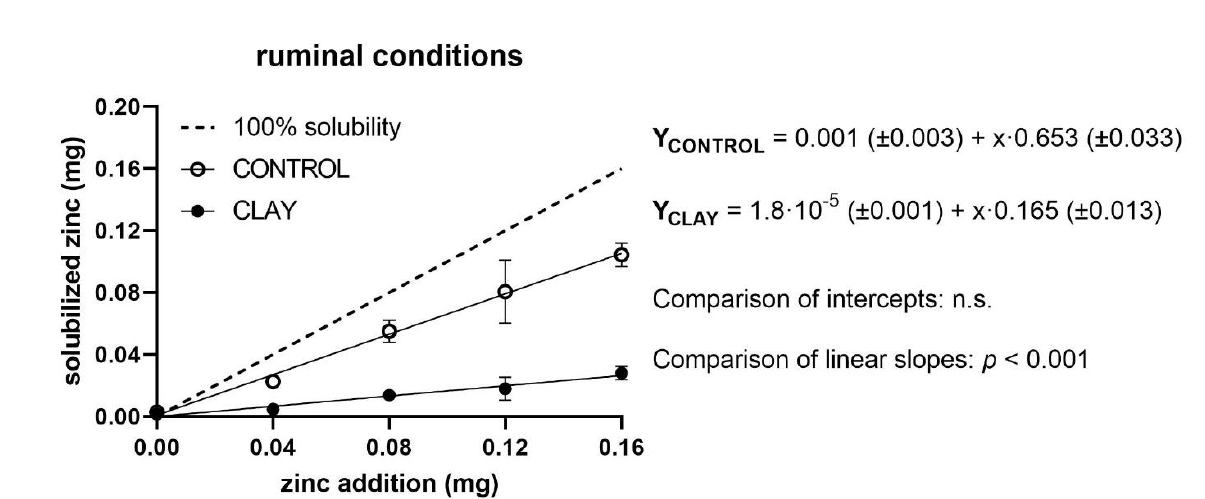
Figure 1. Solubilised zinc (mg) under ruminal conditions with (clay) and without (control) clay mineral addition and supplementation of different zinc doses (mg). The dashed line shows the curve progression at 100% solubility of the added zinc. The p -values display the significance of differences between the intercepts and slopes of the regression line of clay and control (n.s. = not significant).